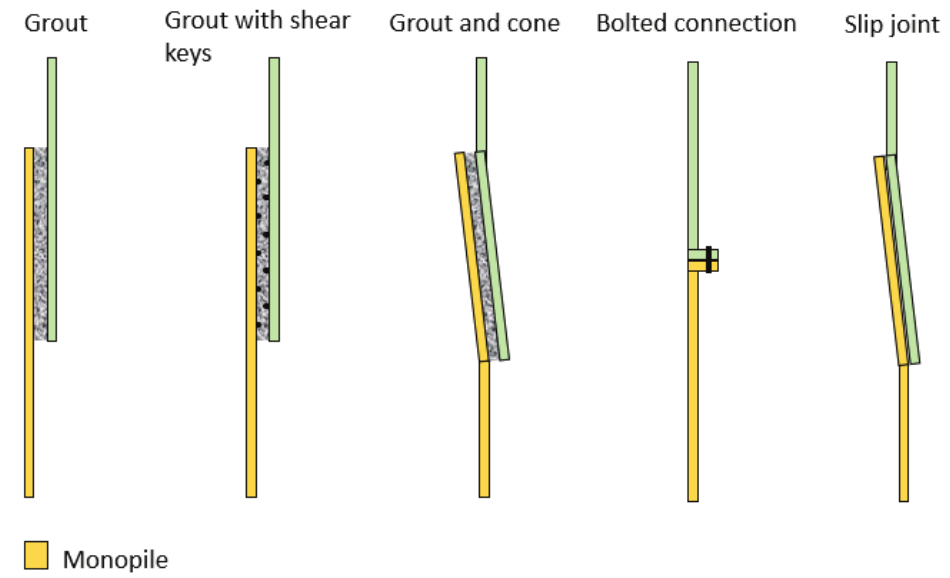
Figure 1. Monopile to transition piece (MP-TP) connection types .